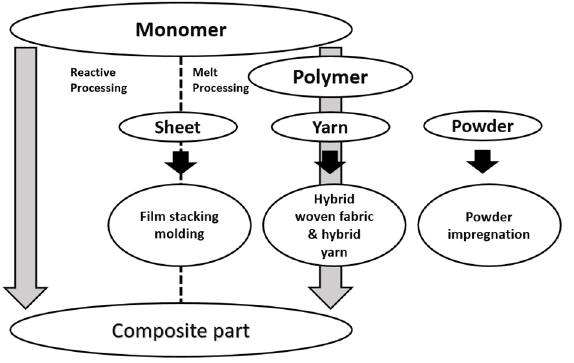
Figure 1. Processing steps for manufacturing thermoplastic composite parts through melt and reac- tive processing. Author’s own figure. reactive processing. Author’s own